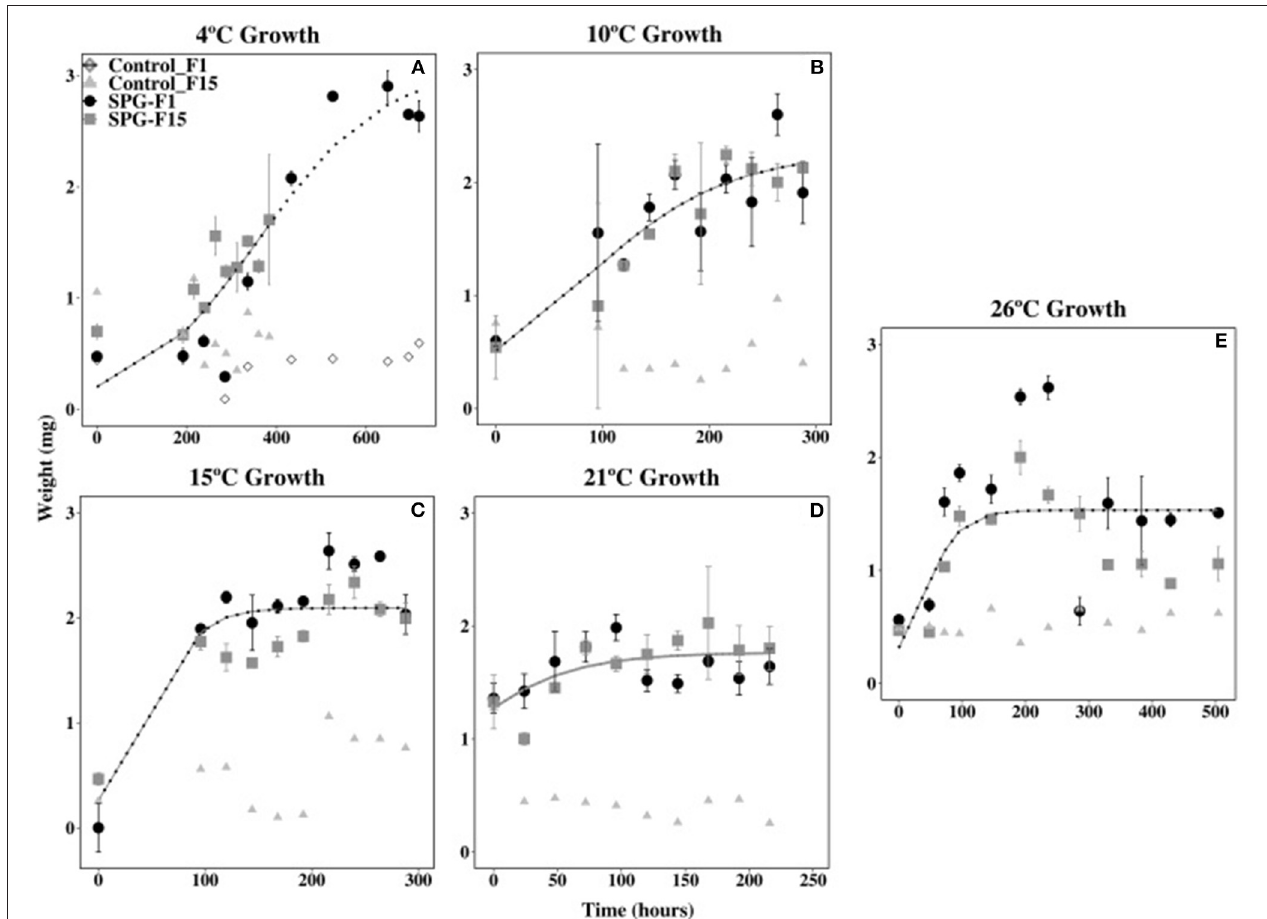
FIGURE 5 | Effect of temperature on SPG-F1 and SPG-F15 growth, measured in mg over time. (A) 4 ◦ C growth. (B) 10 ◦ C growth. (C) 15 ◦ C growth. (D) 21 ◦ C growth. (E) 26 ◦ C growth. Only 4 ◦ C growth has a control for each isolate because the growth analysis was done at different times. Error bars represent standard error calculated for 3 biological